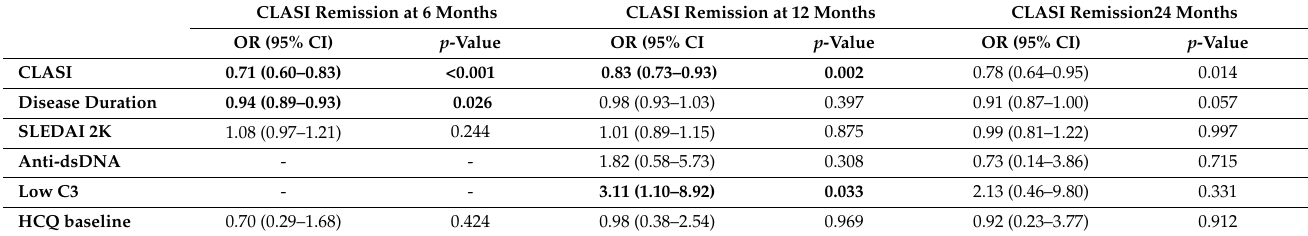
Table 4. Baseline predictors of CLASI = 0 at 6, 12, and 24 months (multivariate analysis).